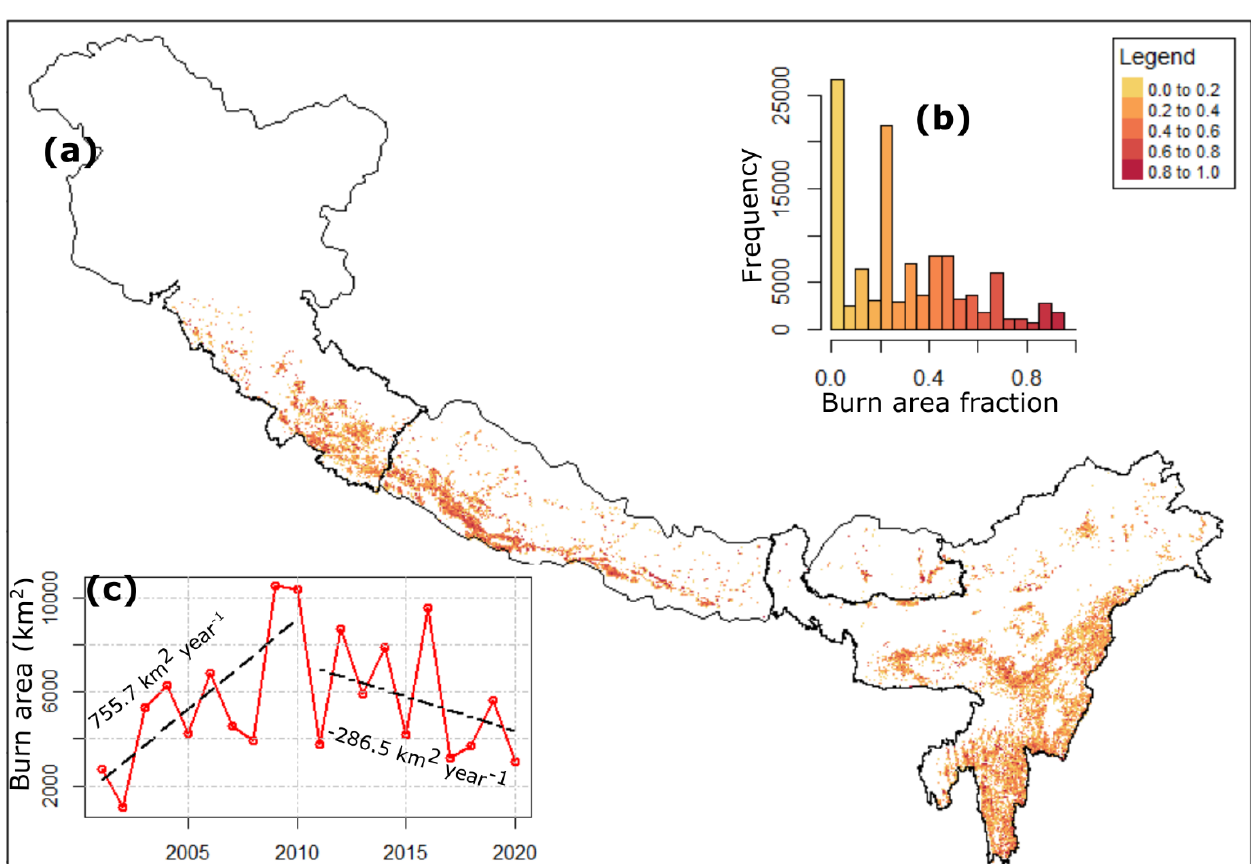
Figure 3. Annual average (2001 – 2020) forest fire burn area fraction (km 2 ) in a 1 × 1 km grid over the study area ( a ), the corresponding histogram of burn area fraction ( b ), and inter-annual variability of forest burn area (km 2 ) ( c ).